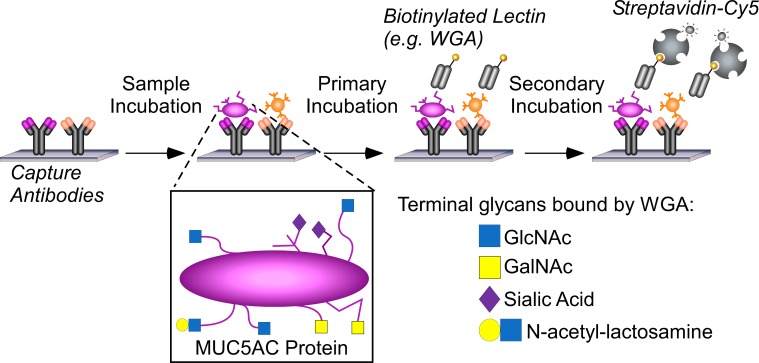
Measuring protein glycoforms in clinical samples.Antibodies immobilized on coated glass slides capture specific proteins out of cyst fluid samples, and lectins or glycan-binding antibodies probe glycans on the captured proteins. We apply each sample to multiple arrays in parallel and probe each array with its own glycan-binding reagent. Some lectins such as wheat-germ agglutinin (WGA) bind several glycan motifs, leaving ambiguity about which motifs are elevated in particular samples.